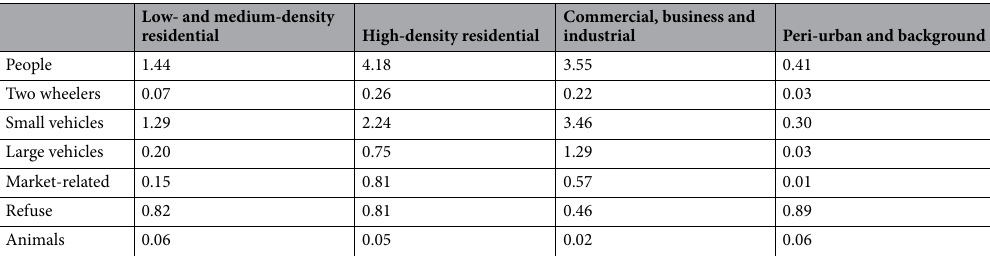
Table 2. Object counts by the type of area on which sites were located. Mean counts per image for each object category, shown in Fig. 5, were averaged across sites by land use